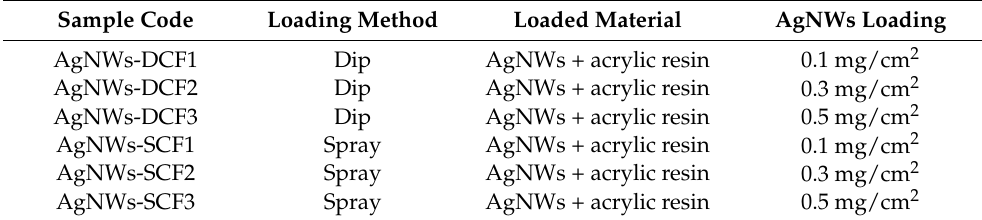
Table 1. Prepared samples with dip- and spray-coating